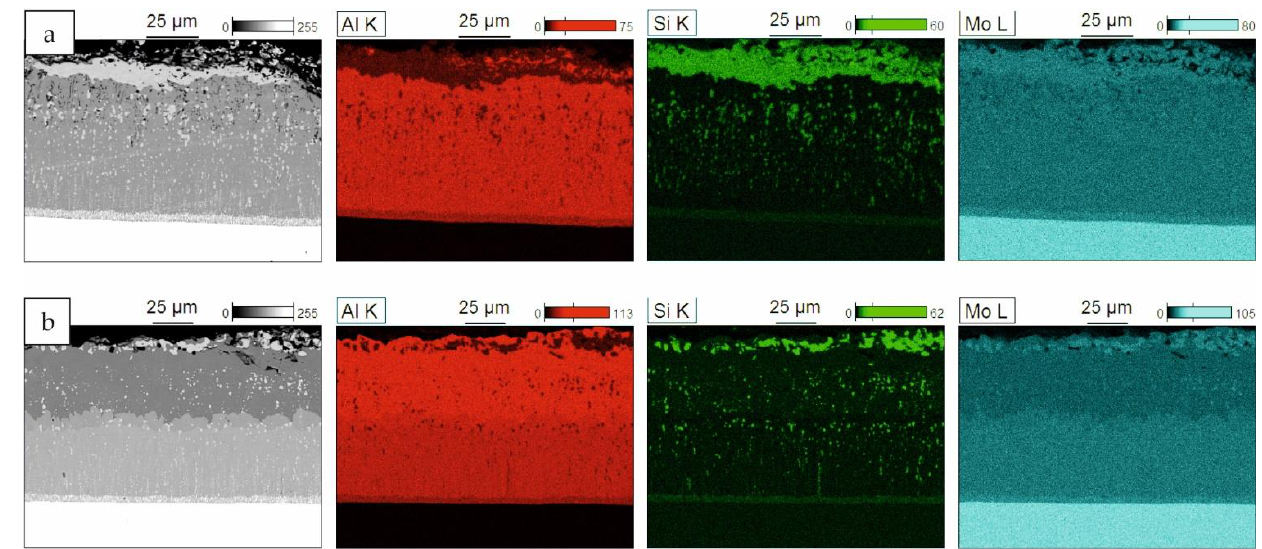
Figure 9. Elemental mapping (BEI/EDS) of cross-sections of Si-Al coatings obtained on TZM alloy at 1000 °C with the slurry volume of ( a ) 0.3 g/cm 2 and ( b ) 0.6 g/cm 2 for 6 h.